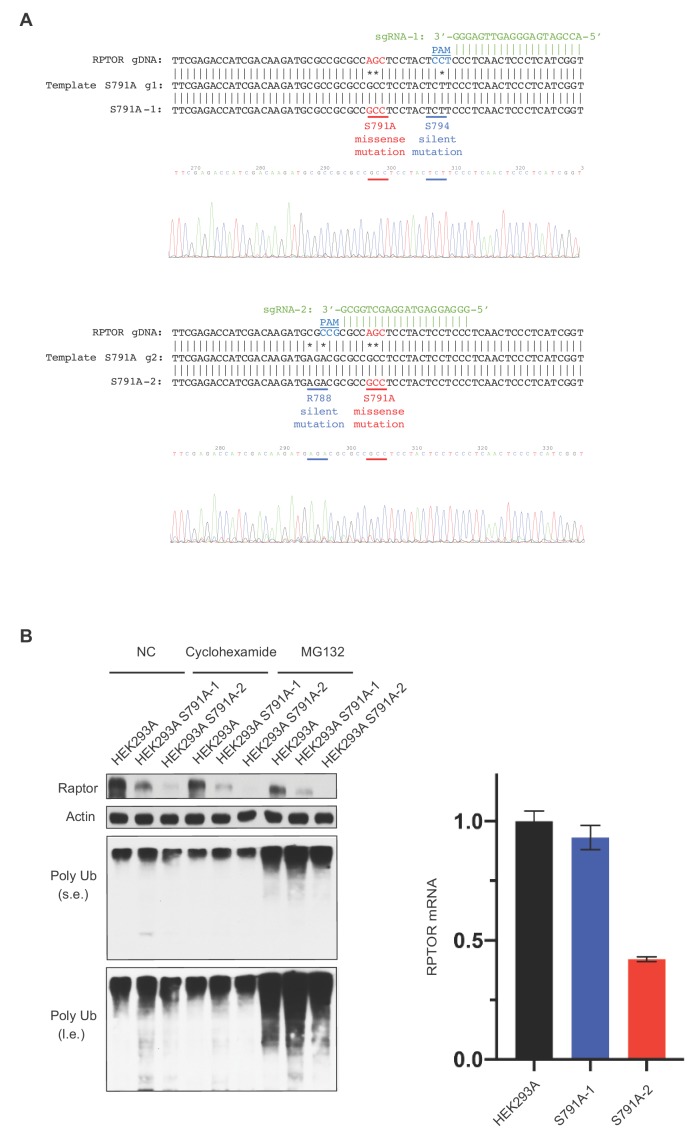
Generation of the Raptor S791A mutant HEK293A cells using CRISPR/Cas9 genome editing.(A) Generation of Raptor S791A cells. Sequence depicting the locus in the RPTOR gene showing the single guide RNA (sgRNA, green), the 5’NGG protospacer adjacent motif (PAM; blue), and the mutation (red) that generates the S791A mutation. (B) Characterization of Raptor S791A cells. Left: HEK293A cells or HEK293A Raptor S791A mutant cells (S791A-1 or S791A-2) were treated with or without cycloheximide (25 ug/mL for 4 h) or MG132 (10 uM for 4 h) and Raptor, Actin, or Poly Ub were analyzed. S.e. denotes short exposure, l.e. denotes long exposure, and NC denotes normal conditions. Right: Raptor mRNA was analyzed in HEK293A cells or HEK293A Raptor S791A mutant cells via RT-PCR. HEK293A vs. S791A-1 (p=0.3622, t-test, error bars were calculated using SEM). HEK293A vs. S791A-2 (p=0.0002, t-test, error bars were calculated using SEM). S791-A vs. S791A-2 (p=0.0006, t-test, error bars were calculated using SEM).